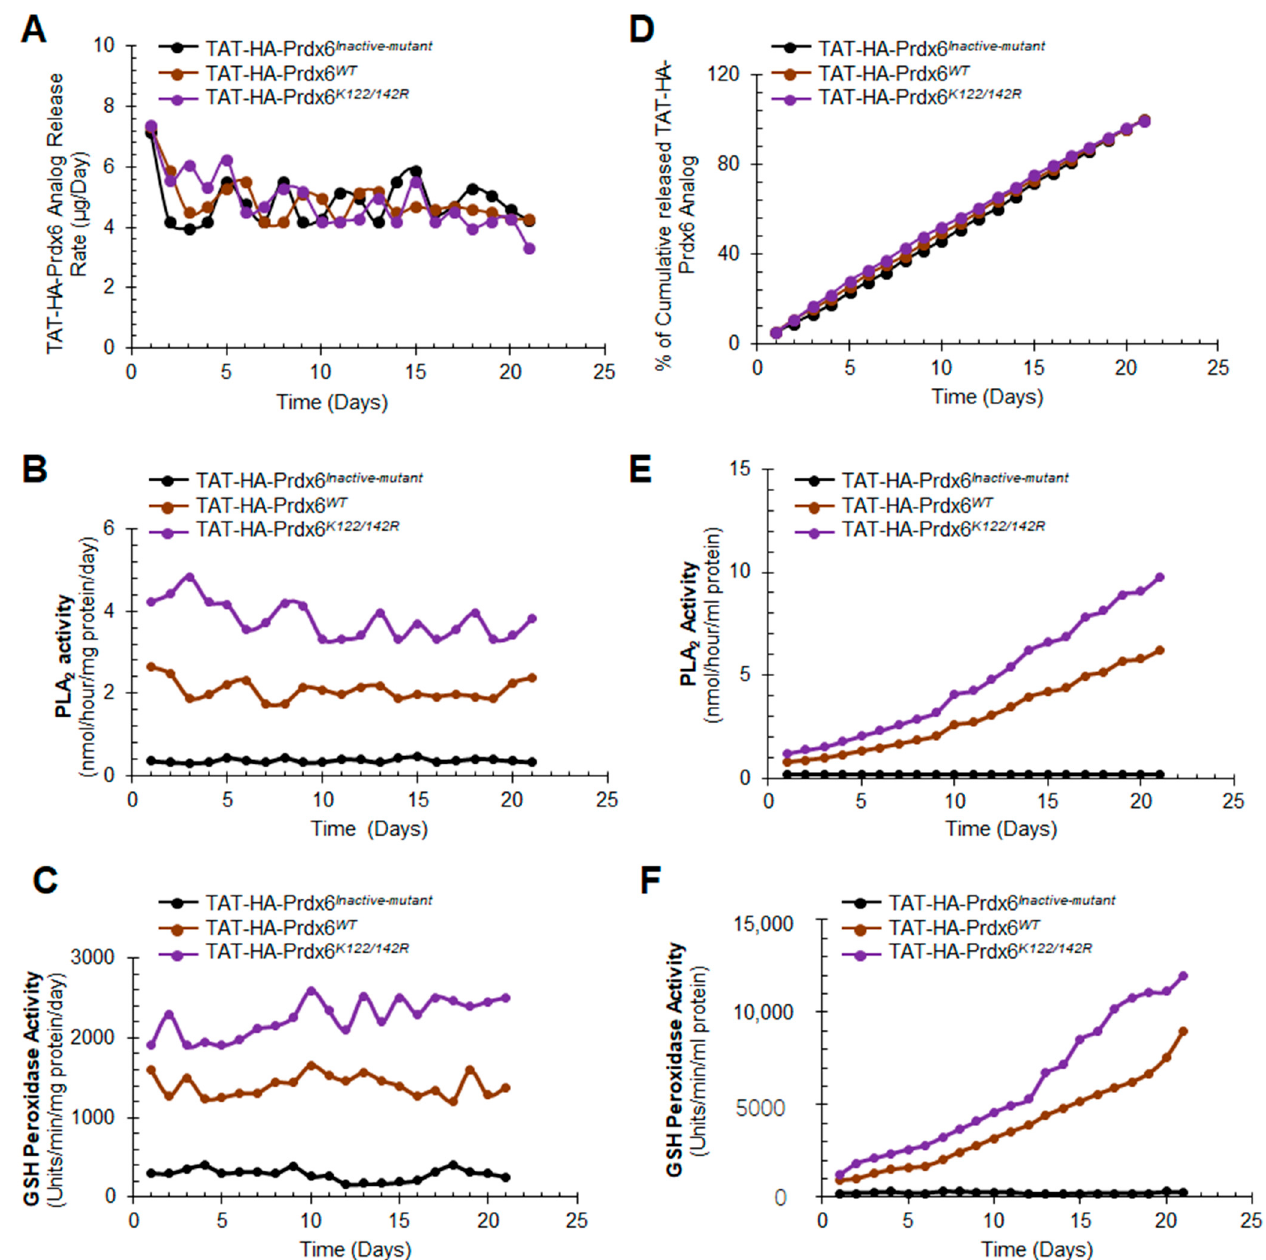
Figure 3. Stability and activity of the TAT-HA-Prdx6 WT , TAT-HA-Prdx6 K122/142R , and TAT-HA-Prdx6 Inactive-mutant protein released from NPs (without Coumarin-6) in PBS (pH 7.3). ( A , D ) Release pattern of TAT-HA-Prdx6 analog from PLGA-NPs in PBS (pH 7.3) at 37 °C using sandwich ELISA method. Equal volume of released protein ( A : Protein released collected at every 24 h and D : Cumulative release of protein collected from 0 to 21 days) were used for the sandwich ELISA assay to measure the availability of the released TAT-HA-Prdx6 analog. The data represent the mean ± SD from three independent experiments. ( B , C , E , F ) Prdx6 activity of TAT-HA-Prdx6 WT or its mutant proteins released from NPs in PBS. Equal volume of released TAT-Prdx6 protein were processed to measure ( B , E ) acidic calcium-independent phospholipase A2 (aiPLA 2 ) and ( C , F ) glutathione (GSH) peroxidase activity following the company’s protocols and described in our published reports [10].